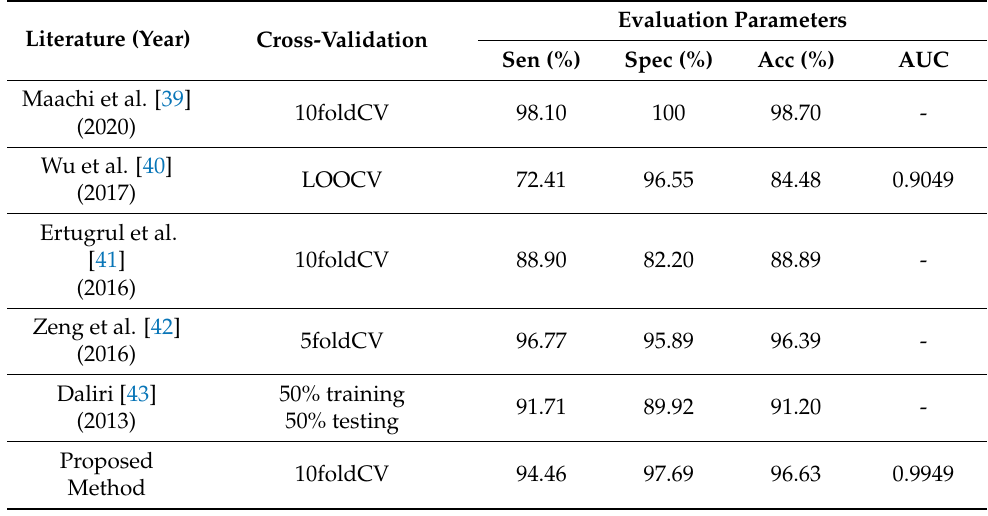
Table 25. Two-class classification results of comparisons with existing literature for all datasets.